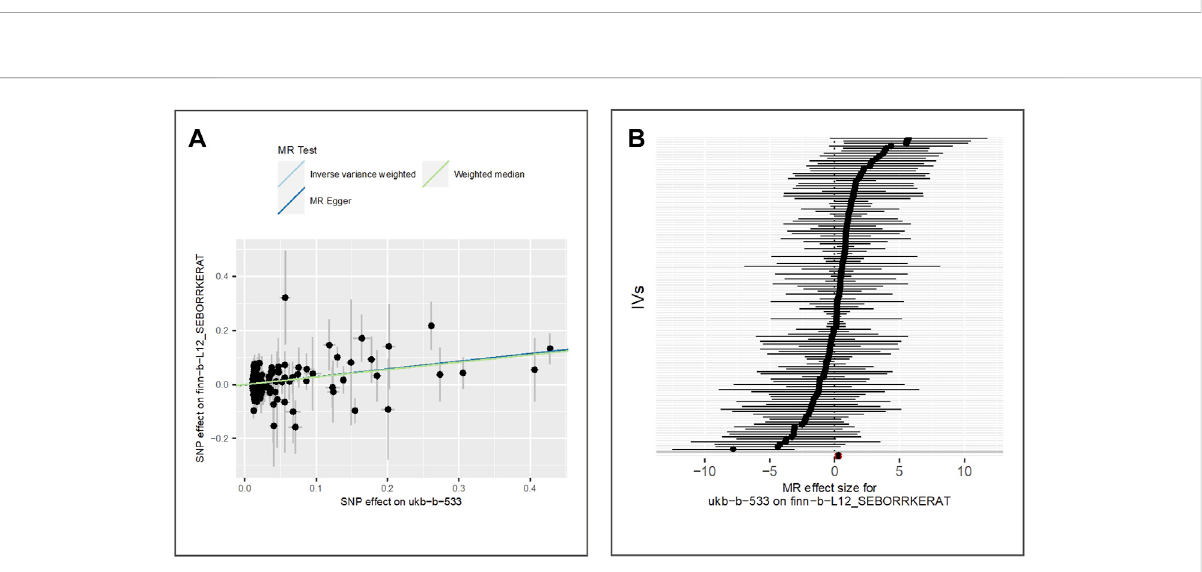
FIGURE 3 Comparison ofMRmethodsand resultsassociatedwith seborrhoeic keratosis: (A) scatter plotre fl ects SNPeffects ontheseborrhoeickeratosis against SNP effects on the exposure; (B) forest plot represents the causal effect of exposure on the outcome using each SNP